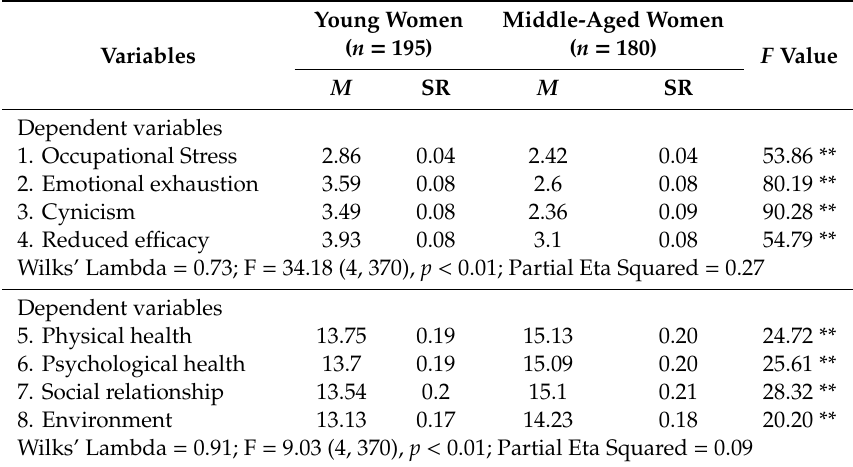
Table 3. One-way multivariate analysis of variance (MANOVA) ( N =